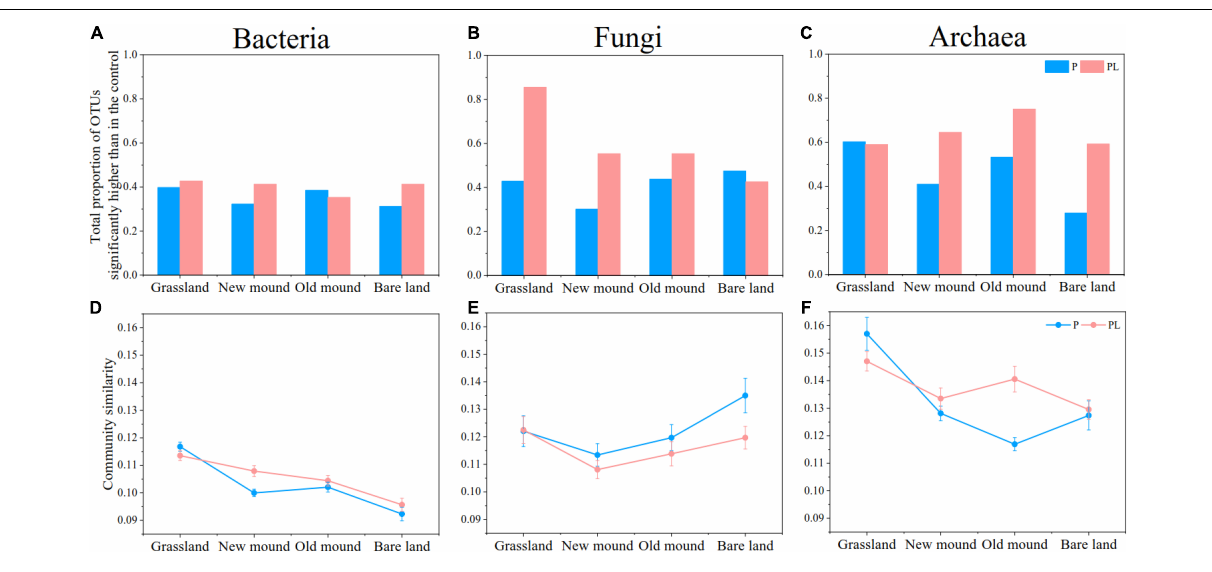
( Figure 5 ). The potential links between OTUs under only pika disturbance were stronger than those under mixed